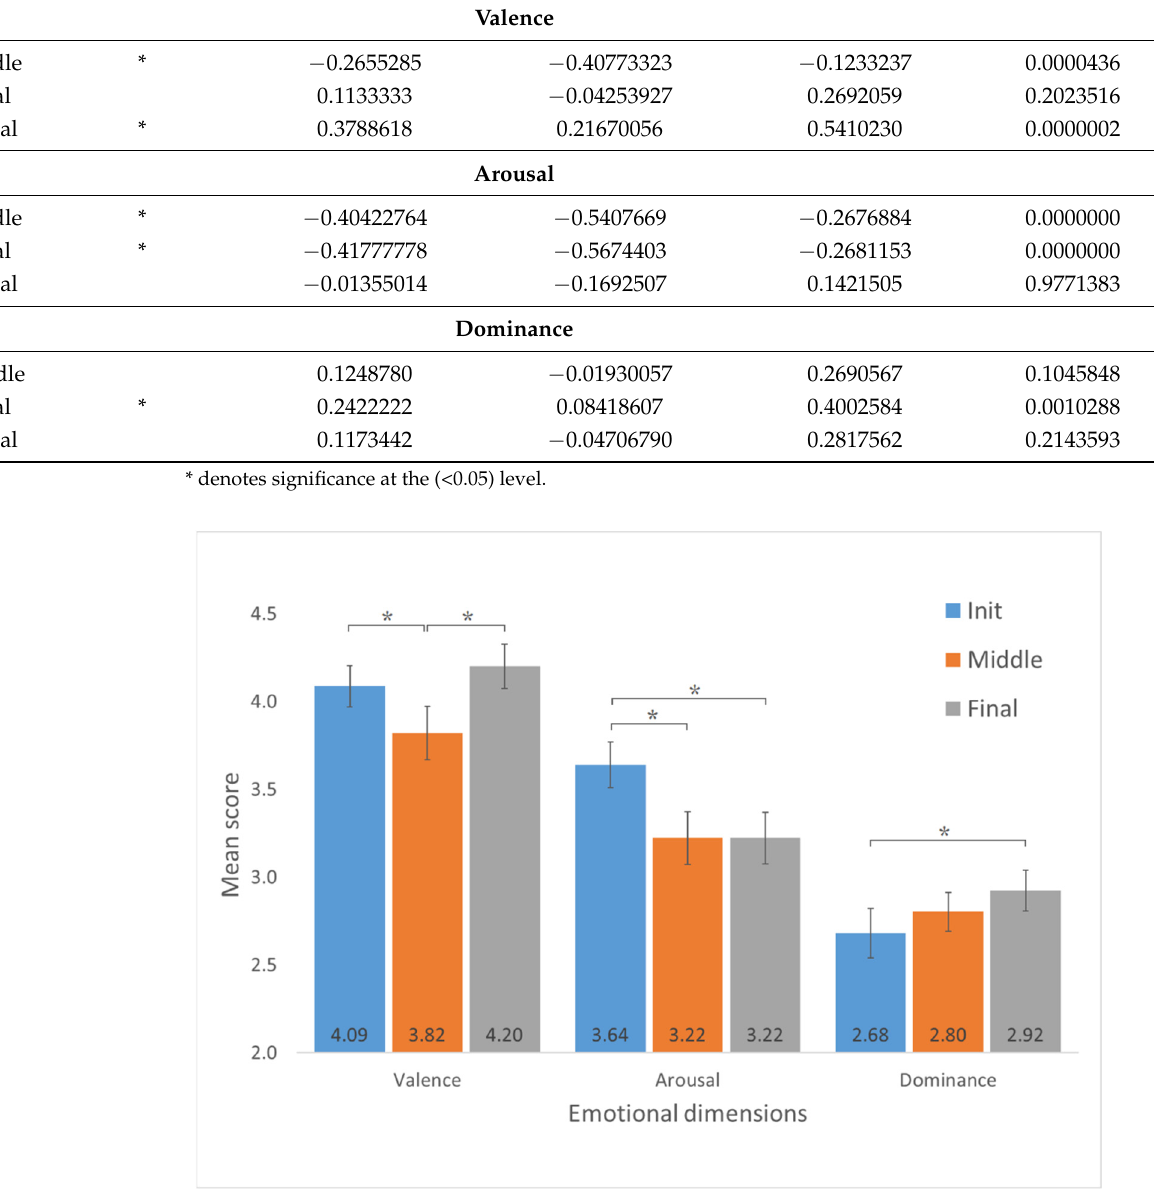
Table 7. Results from the SAM tests showing the significant differences between rehabilitation phases.